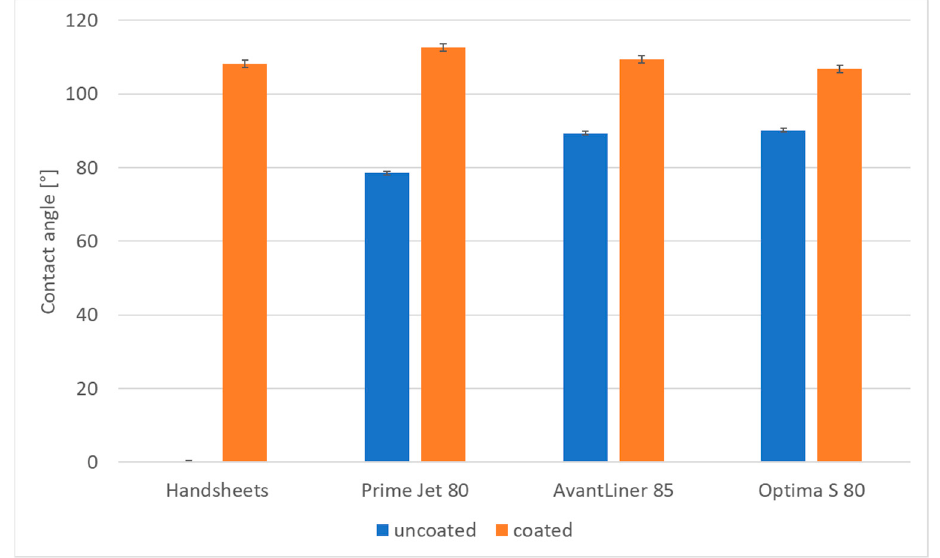
Figure 1. Average water contact angle of uncoated and coated samples of the papers.